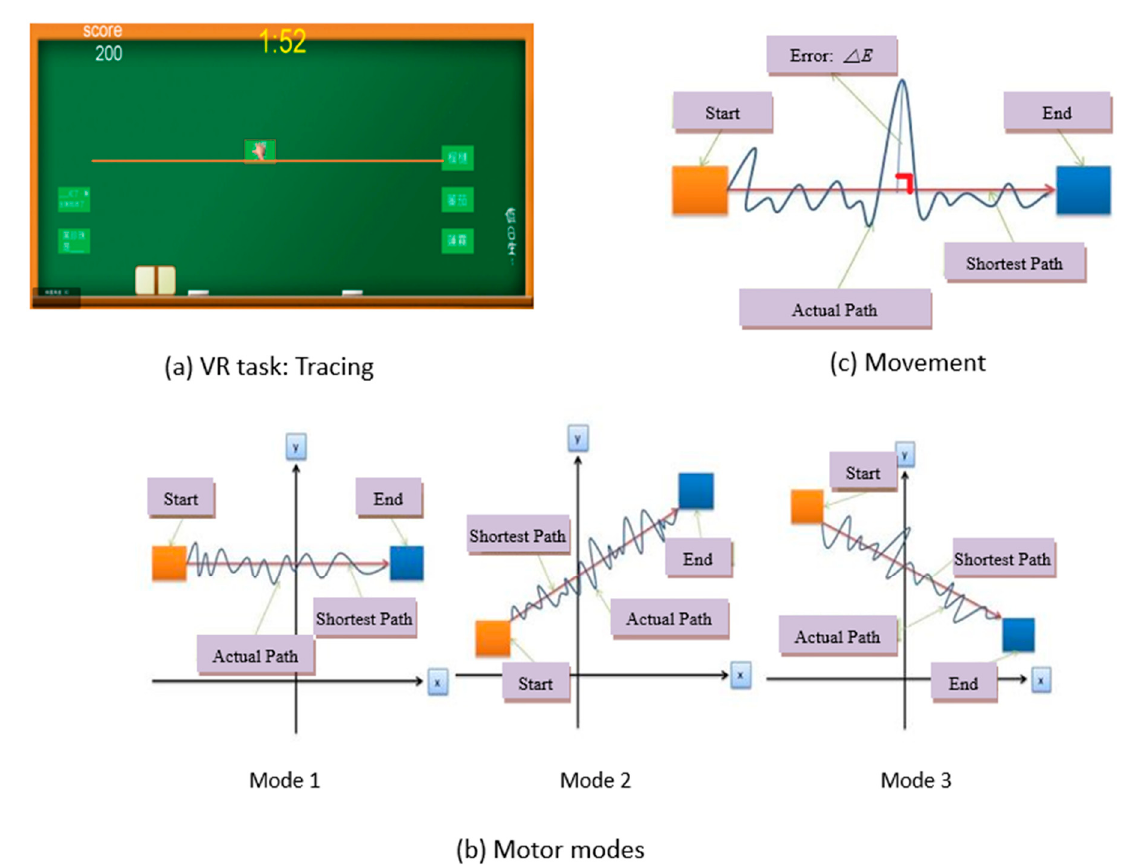
Figure 2. VR task: